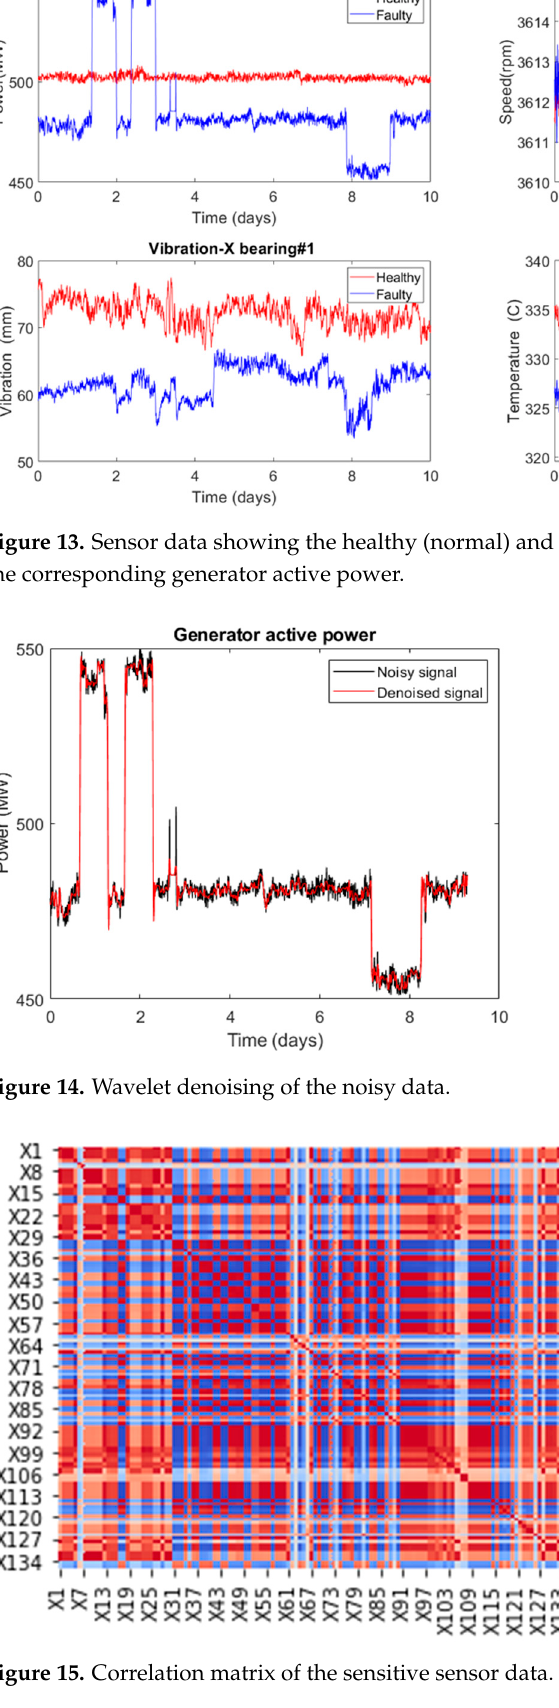
Figure 15. Correlation matrix of the sensitive sensor data.